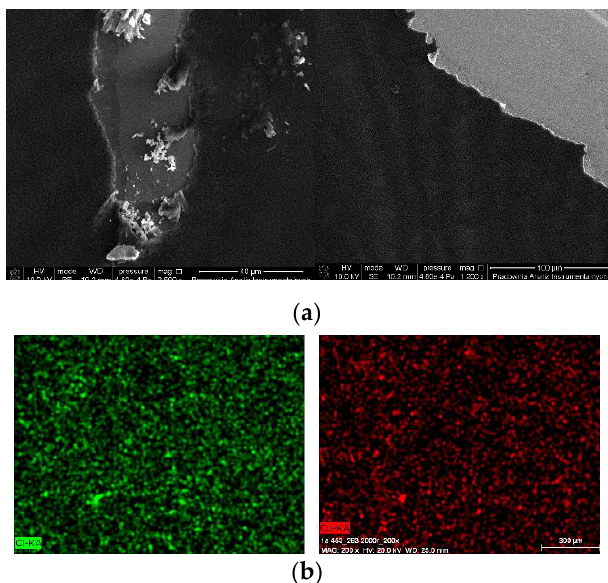
Figure 12. SEM of ( a ) {[Cu 2 (L1)Cl 2 ] 2 [CuCl 4 ]} · 2MeCN · 2H 2 O 1 / PMMA / Si PMMA 3000 rpm 5 s, 3000 rpm PMMA + complex 1 × 2 {[Cu 2 (L1)Cl 2 ] 2 [CuCl 4 ]} · 2MeCN · 2H 2 O 1 3000 rpm × 4, 5 s, ( b ) EDS mapping of [Cu 2 (L2)Cl 3 ] 0.5 MeCN · 2 / PMMA / Si, scan size 1 µ m, 3000 rpm PMMA × 1, complex 2 3000 rpm × 2, complex + PMMA 3000 rpm × 1, complex 3000 rpm × 1, 5 s.